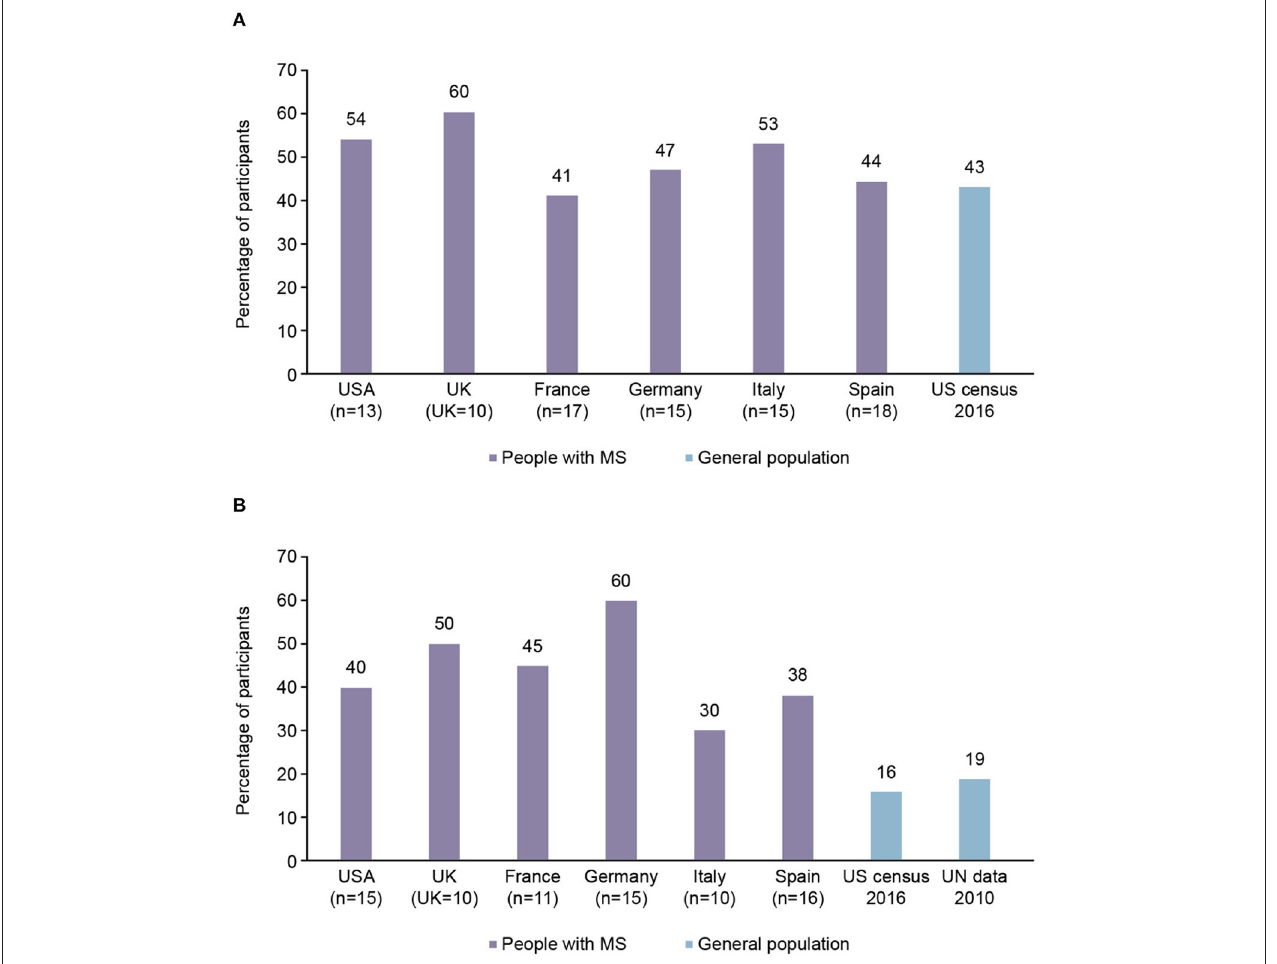
FIGURE 2 | Proportion of participants with multiple sclerosis (MS) from each country aged 26–45 years with no children, compared with general population findings. (A) 26–35 years of age subgroup. (B) 36–45 years of age subgroup.